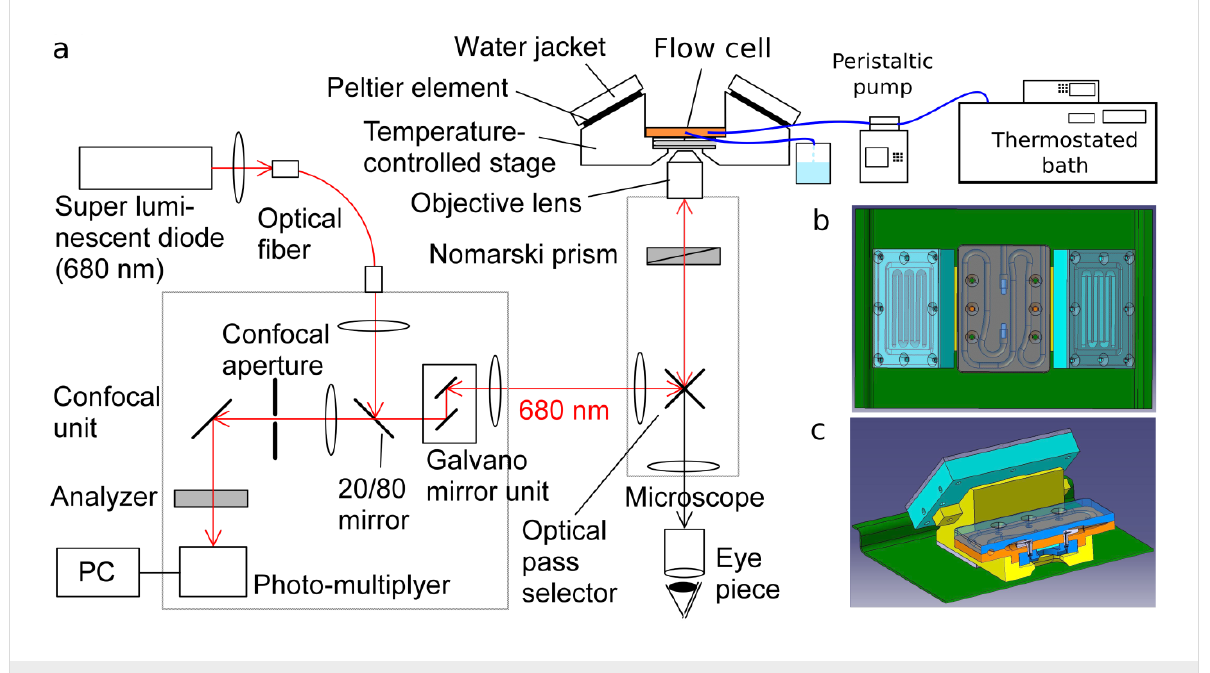
Figure 6: Schematic representation of the experimental setup: (a) Laser confocal differential intereference contrast microscope, (b) top view, and (c) a cross-sectional view of the temperature-controlled observation flow cell.